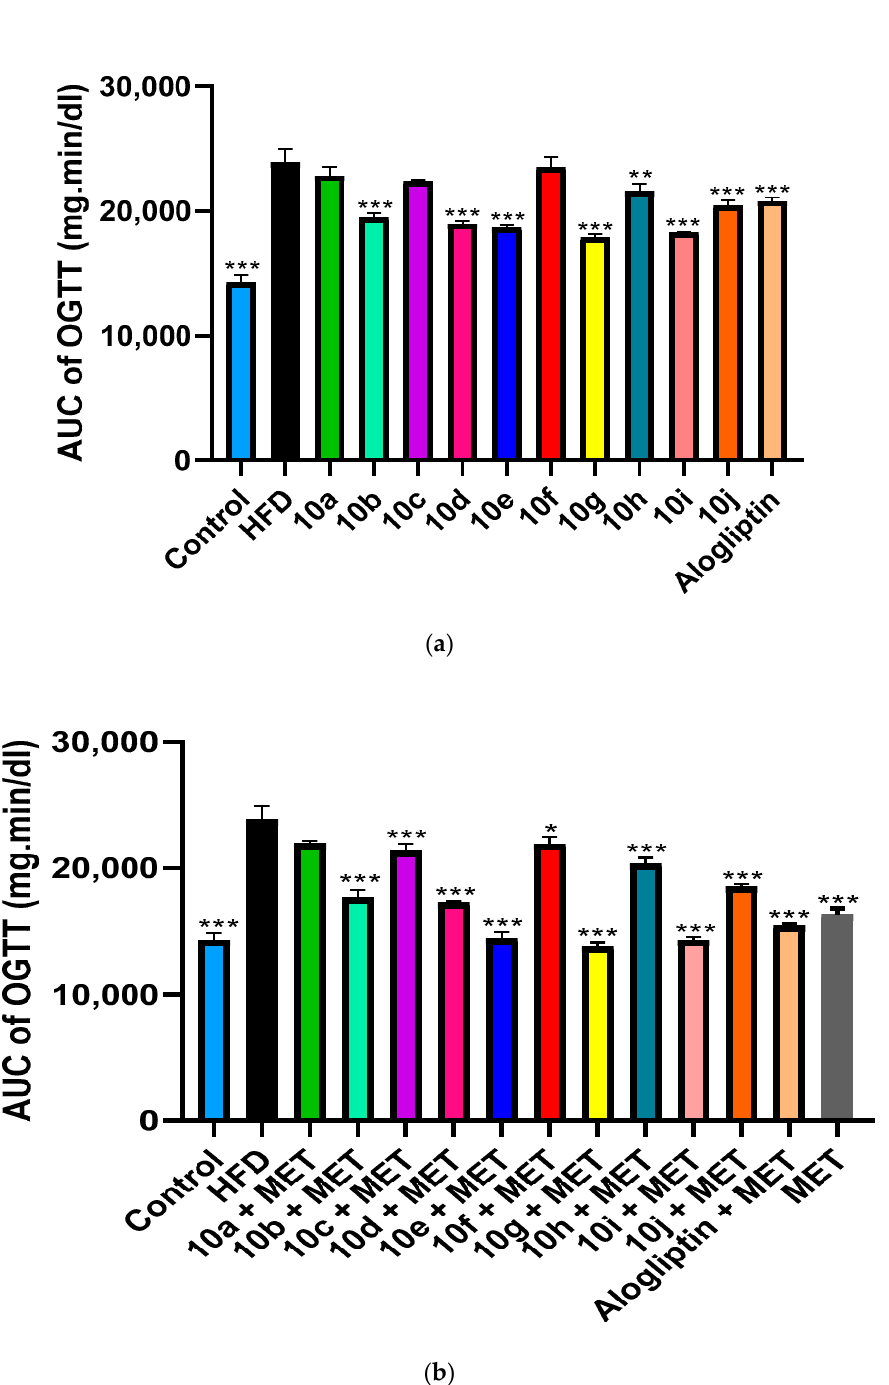
Figure 4. ( a ) Chronic effect of hybrids 10a–j and alogliptin administration on blood glucose levels during an OGTT in type 2 diabetic rats. Data are presented as mean ± SEM (n = 7). ( b ) Chronic effect of combined administration of 10a–j /MET, alogliptin/MET on blood glucose levels during an OGTT in type 2 diabetic rats. Data are presented as mean ± SEM (n = 7).